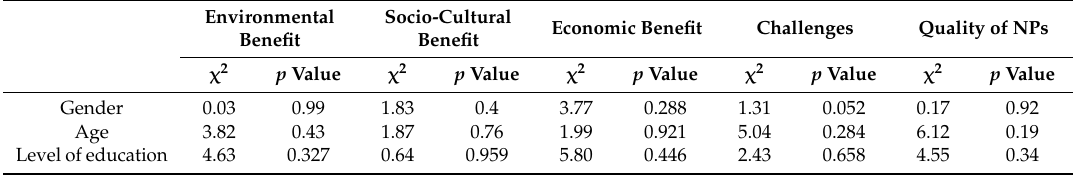
Table 6. Chi-square value of the respondents’ characteristics and perceived benefit and problem and attitude towards the quality of